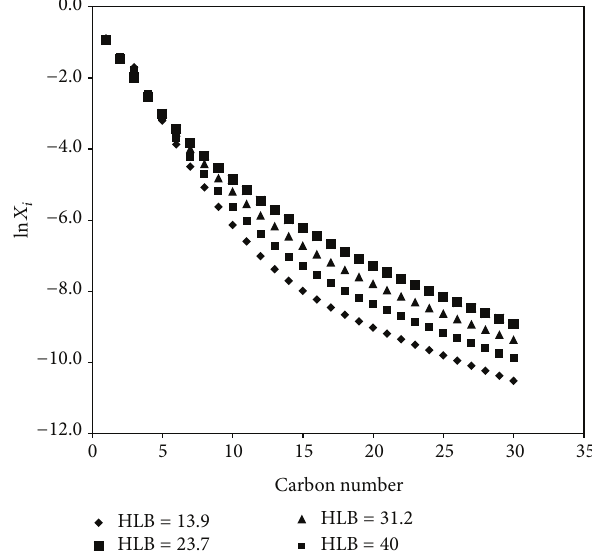
Figure 9: Overall products distributions on catalysts after 35h time- = 1 ,space on-stream,reactionconditions:583 K,17bar, ( H 2 / CO ) feed −1 ((a) HLB = 13.9, (b) HLB = 23.7, (c) velocity of 4.9 nl ⋅ h −1 ⋅ g Fe HLB = 31.2, and (d) HLB =